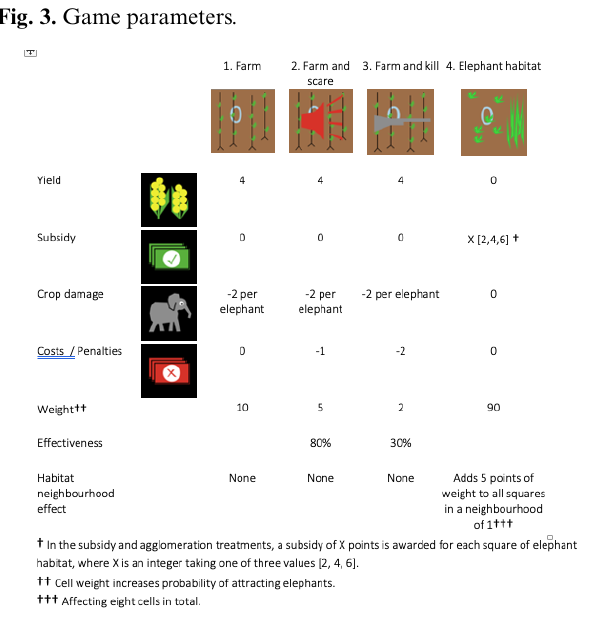
Fig. 3. Game parameters.